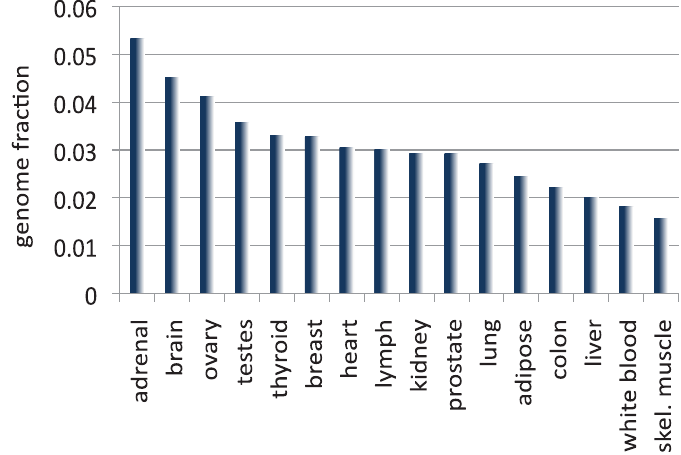
Figure 2. The size of the transcriptome, computed as the fraction of the total number of base pairs in the human genome covered by the assembled transcripts, for 16 normal human tissues included in the Illumina Body Map [98]. Each RNA-seq data set was mapped to the genome with TopHat [78] and assembled with Cufflinks [41]. Note that except for adrenal tissue, in which transcripts cover 5.3% of the human genome, all other reconstructed transcriptomes are smaller in size than the currently annotated